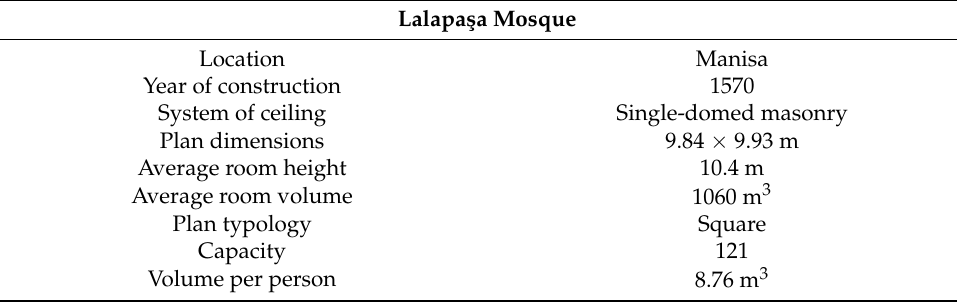
Table 1. The architectural features of Lalapa¸sa